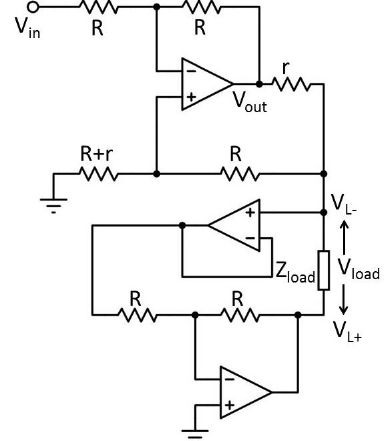
Fig.4: Enhanced Howland Current Source with Bridge topology (BRIDGE-2).